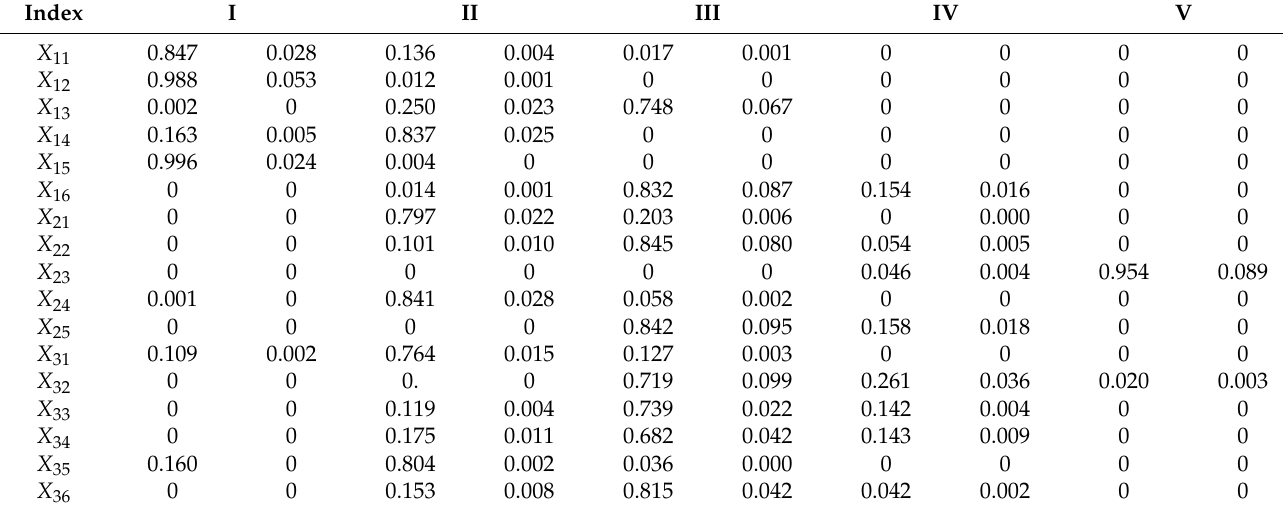
Table A7. Cloud correlation degree of secondary